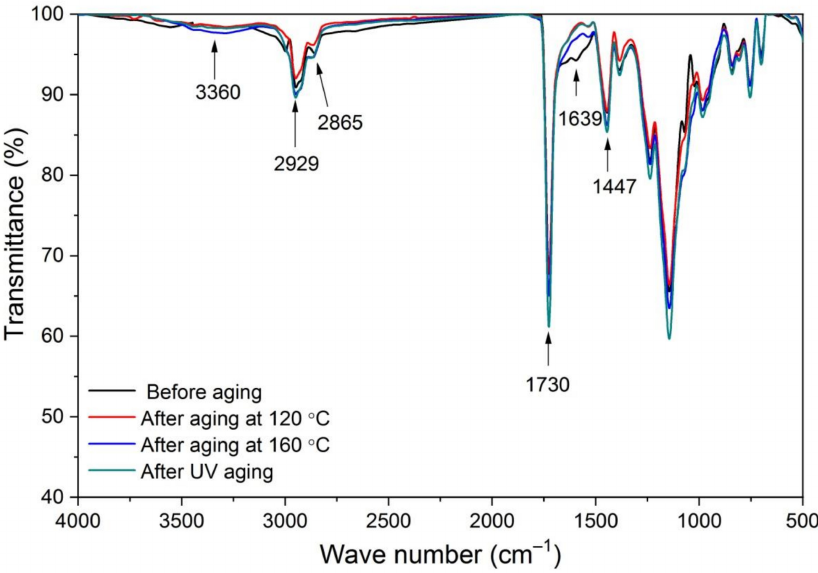
Figure 10. FT-IR of the coating film containing microcapsules.